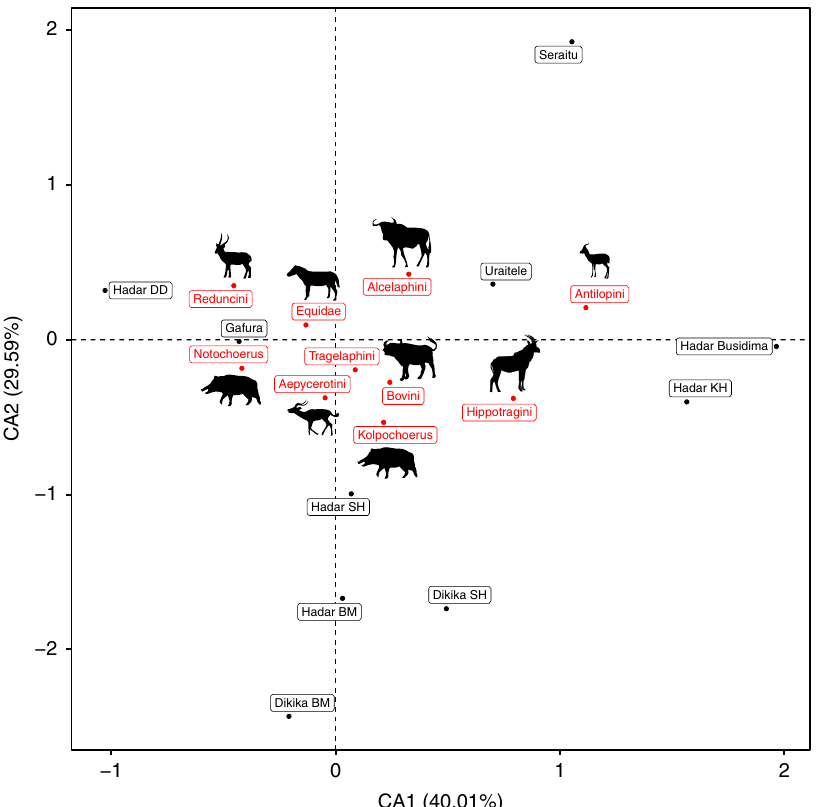
Fig. 5 Correspondence analysis on taxon abundances comparing the MLP faunal zones with assemblages from the Hadar Formation at Hadar and Dikika. Results demonstrate that the Gafura assemblage is distinct from the Seraitu and Uraitele assemblages, with Gafura showing a high abundance of Notochoerus , and the Seraitu and Uraitele assemblages showing a high abundance of Alcelaphini and Antilopini, which are open-habitat indicator